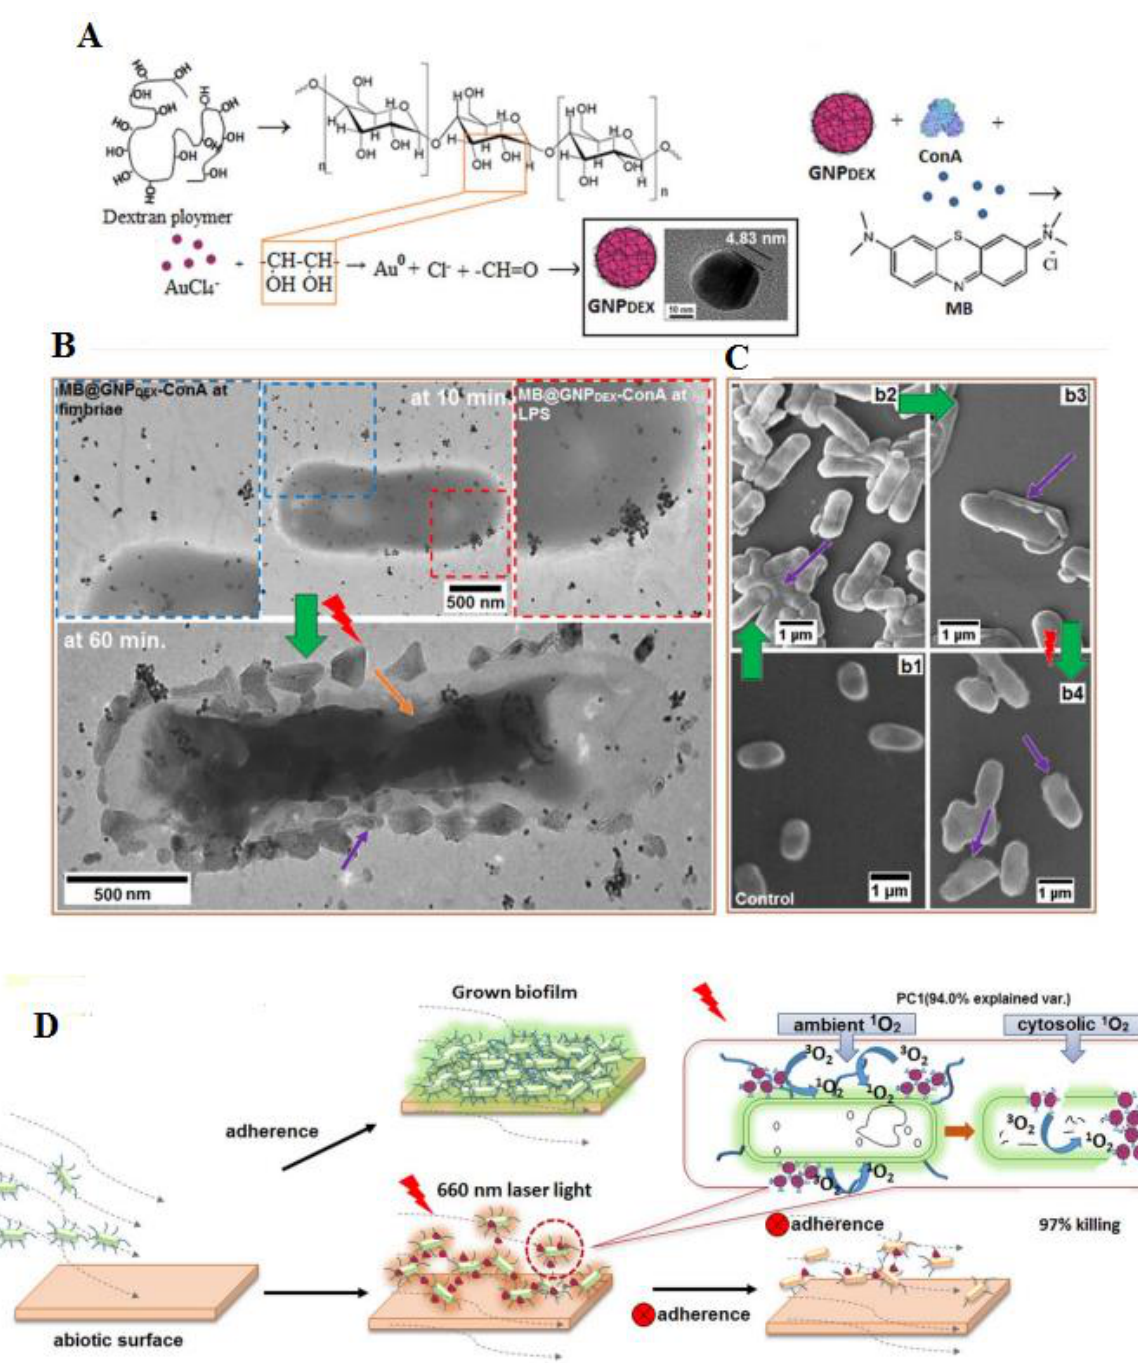
Figure 7. Schematic representation of the synthesis of dextran capped AuNPs ( A ). TEM image of localized MB@GNPDEX-ConA on K.Pneumoniae -12 bacterial surface and treatment. The schematic displays the cytological mass with accumulated conjugates (yellow arrow) and cell surface discomposure ( B ). The uniform morphology of bacterial aggregation and control cells according to concanavalin A (ConA)-mediated connection of conjugates ( C ). With light irradiation, the singlet oxygen produces ambient 1 and cyto O 2, however, the cytosolic singlet oxygen influence the bactericidal effect and the absence of adherence through ambient oxygen. Singlet oxygen around the bacterial cells decreases the adherence ability ( D ) [158] Reprinted with permission from Elsevier. Table 2 displays other examples of the application of Au NPs in antimicrobial resistance activity (AMR).